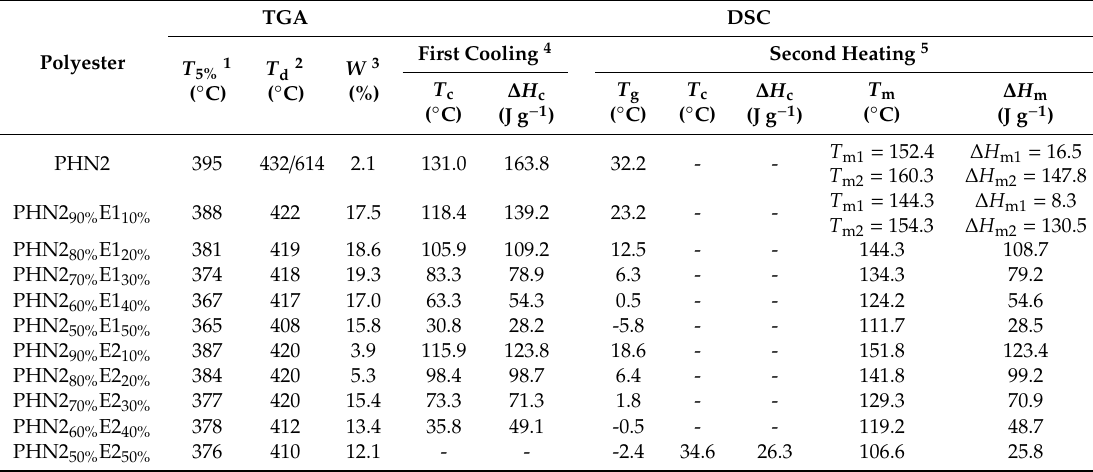
Figure 6. TGA derivative curves of PHN2 1 − x E1 x recorded from 25–800 ◦ C at a heating rate of 10 ◦ C min − 1 under a nitrogen atmosphere. Table 2. Thermal property parameters of PHN1 1 − x E1 x and PHN1 1 − x E2 x